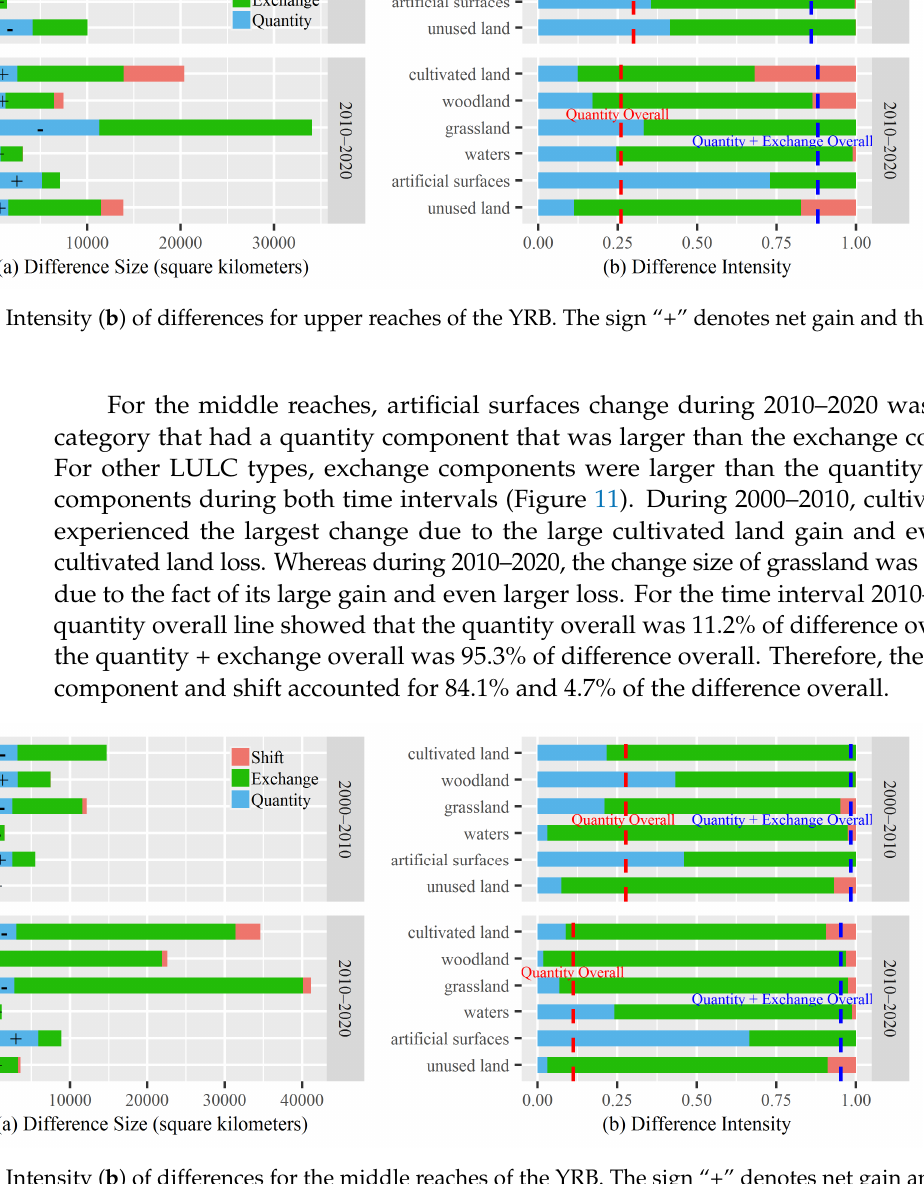
Figure 11. Size ( a ) and Intensity ( b ) of differences for the middle reaches of the YRB. The sign “+” denotes net gain and the sign “−” denotes net loss.